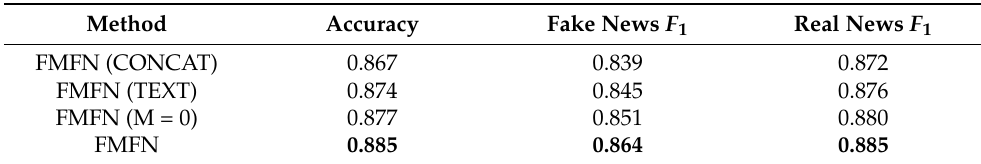
Table 3. The results of FMFN (CONCAT), FMFN (TEXT), FMFN (M = 0), and FMFN.